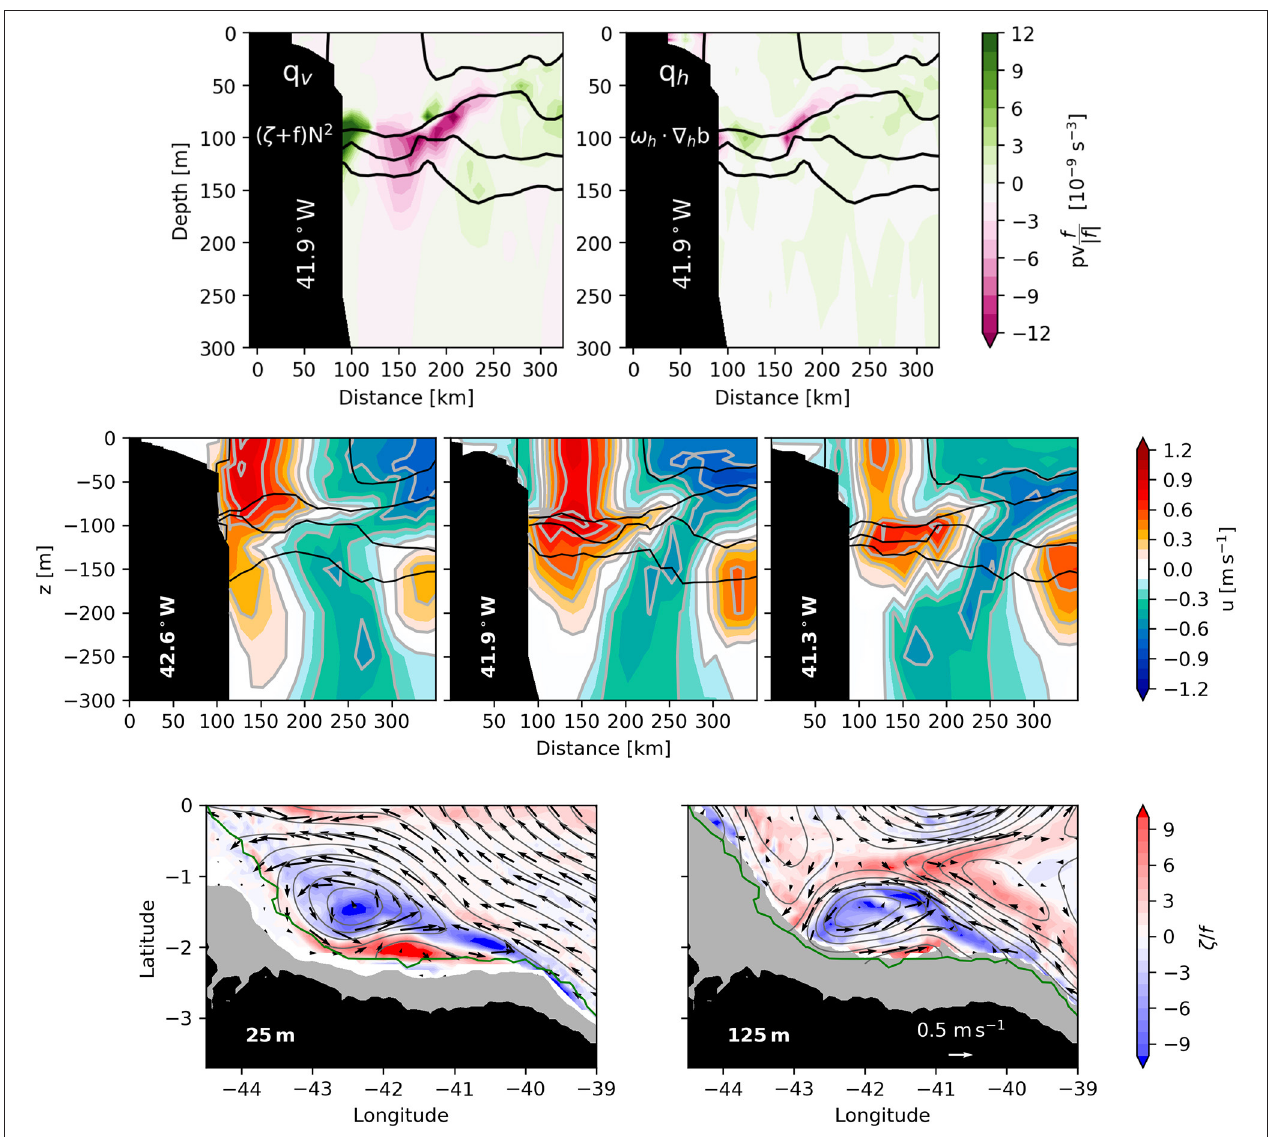
FIGURE 5 | (Top) The vertical section for vertical (left) and horizontal (right) components of potential vorticity and density lines (black) at 41.9 ◦ W. ω h includes the meridional component of Coriolis parameter. (Middle) The vertical section for along-slope velocity and density lines (black) at 42.6 ◦ W (left), 41.9 ◦ W (center), and 41.3 ◦ W (right). Eastward velocities are positive. (Bottom) The local Rossby number ( ζ/ f ), objective mapped stream function, and velocity field anomaly for 25 m (left), and 125 m (right). The green line in the plots represents the 50m isobath. All the plots are for HR19.1 in June 9,